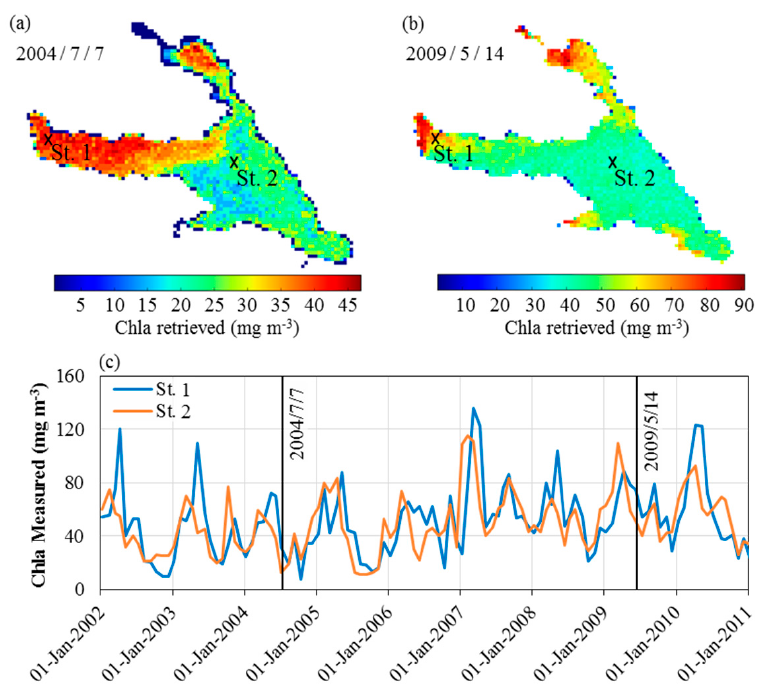
Figure 9. Spatial distribution of Chla concentration for Lake Kasumigaura was generated using MAIN-LUT for MERIS images on ( a ) 7 July 2004 and ( b ) 14 May 2009; and ( c ) the time series of monthly measured Chla concentration in Lake Kasumigaura at station 1 and station 2 from 2002 to 2011. The two black lines on the time series chart represent the dates of the two images.